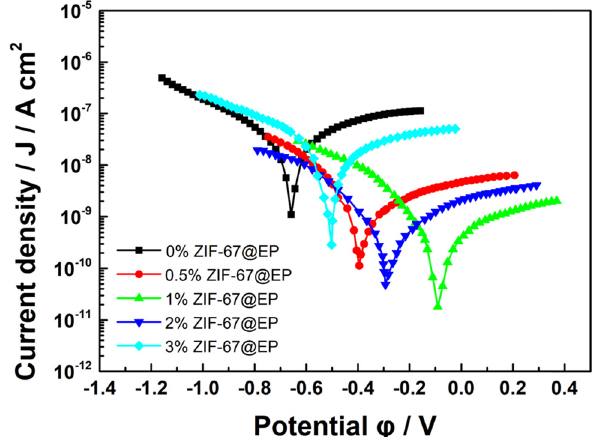
Figure 5: OCP of the substrates protected by di ff erent coatings after 0, 7, and 14 days of immersion in 3.5% NaCl ( aq ) .